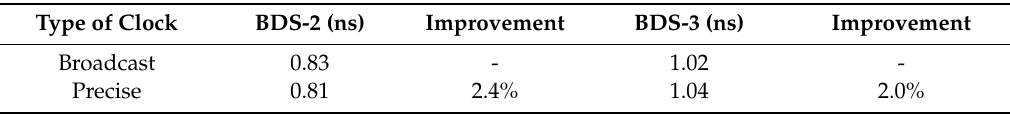
Table 7. The daily average accuracy of the ultra-rapid clocks resulting from two types of clocks and the corresponding